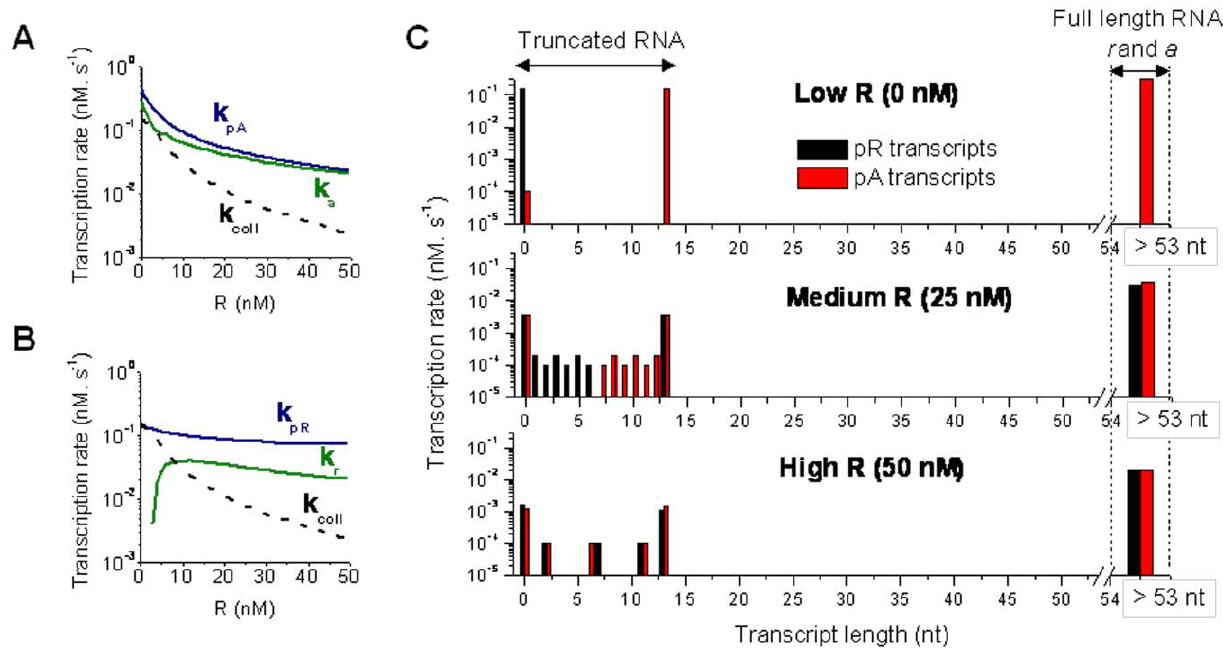
Figure 3. Transcriptional Interference within scbA-scbR locus. ( A–B ) Transcription rates k a and k r from promoters pA and pR respectively in presence of TI, the RNAP firing rates k pA and k pR from promoters pA and pR respectively in absence of TI, and the net rate of RNAP collisions k coll due to sitting duck collisions and collision between elongating RNAP, shown for different concentrations of repressor ScbR. ( C ) Transcription rate of different sizes of truncated RNA ( , 53 nt) and full-length RNA ( a and r ) from promoters pR and pA for different levels of repressor